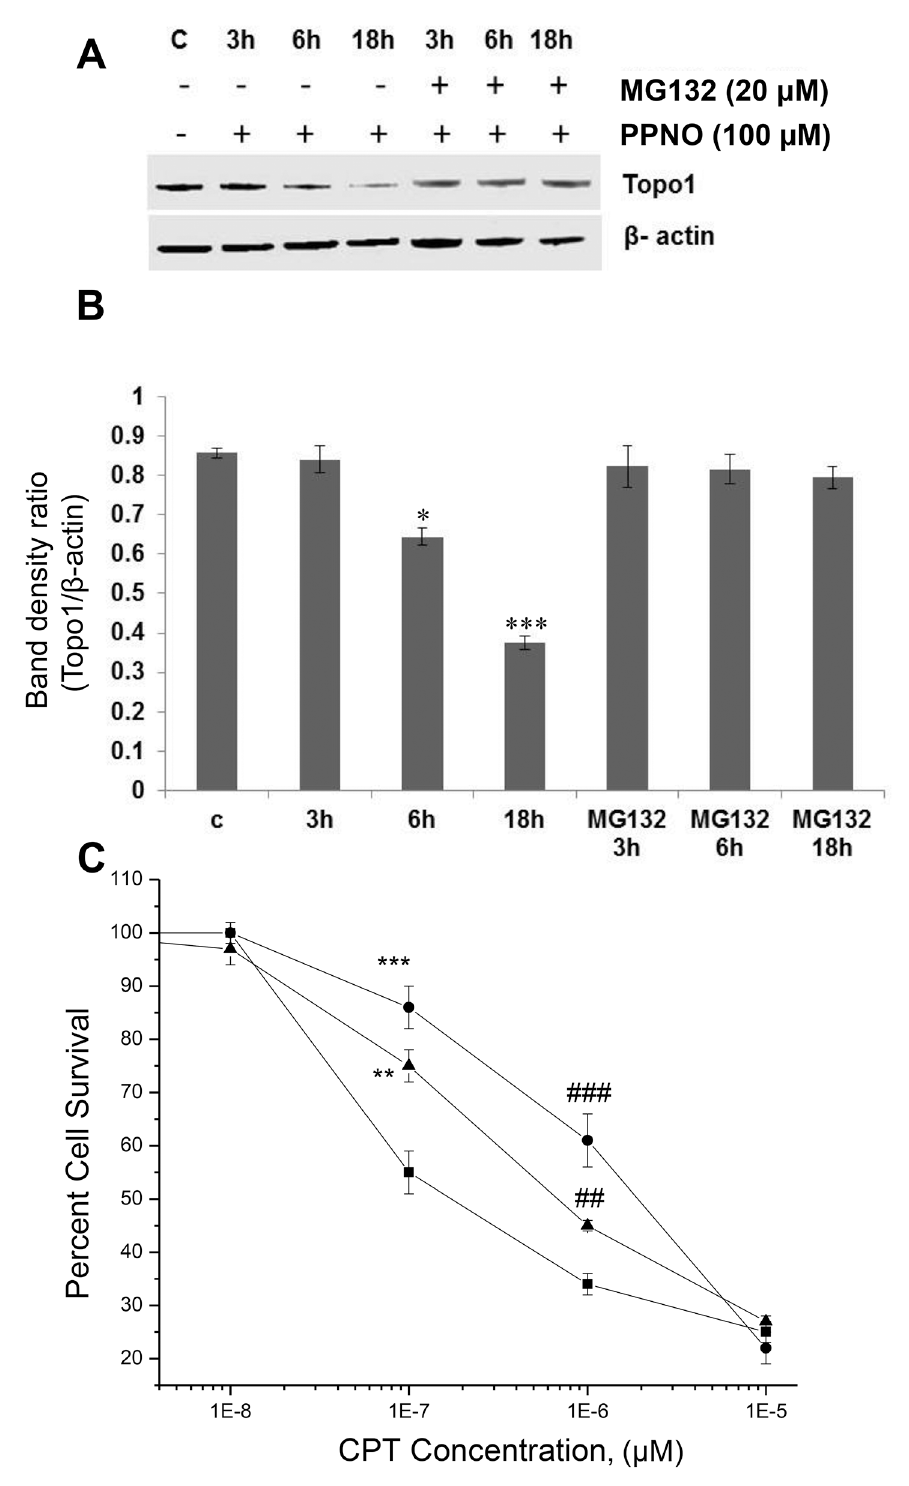
Fig 4. (cid:1) NO-induced down-regulation of topo I protein levels in MCF-7 cells. (A) Cells were treated for various times with PPNO and cells were collected, lysed and analyzed by Western blots for topo I, (B) Quantification of the resulting topo I protein levels, and (C) Cytotoxicity of CPT ( ■ - ■ ) alone and in the presence of PPNO (100 μ M; ● - ● , 50 μ M; ▲ - ▲ ) in MCF-7 cells. Values are mean SEM from at least 3 separate experiments carried out in triplicate (n = 3). * P < 0.05, ** P < 0.01, # # and *** P < 0.001, # # # and with respect to concentration-matched